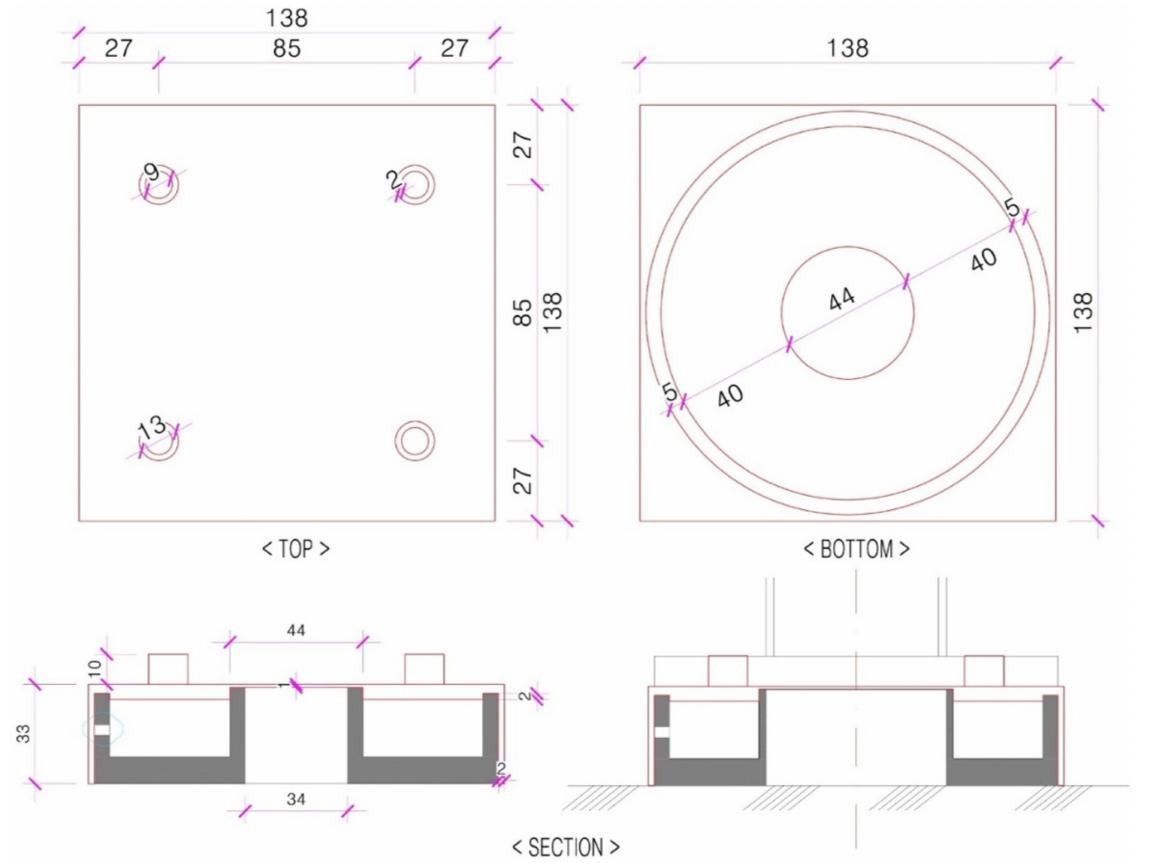
Figure 8. Load cell rubber casing design.